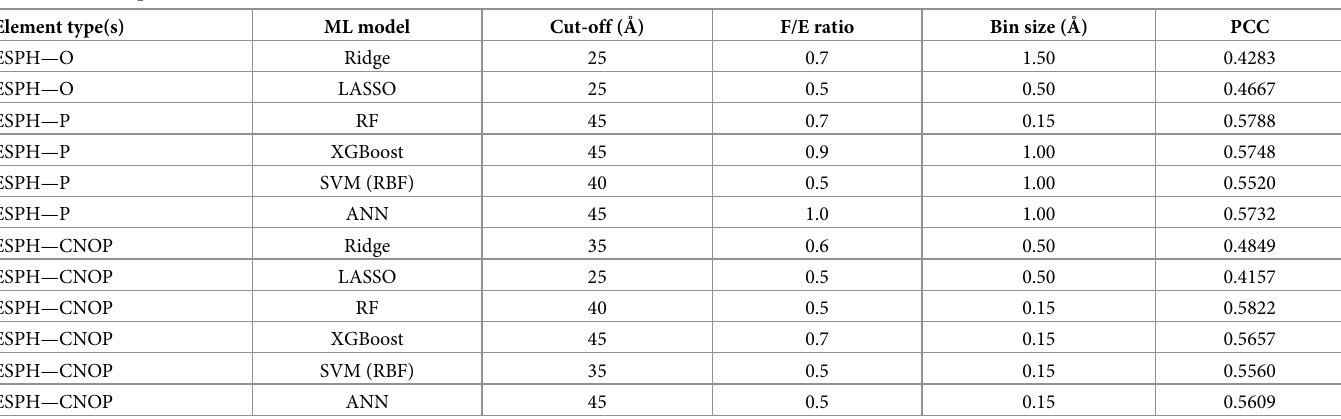
Table 3. Best test performance